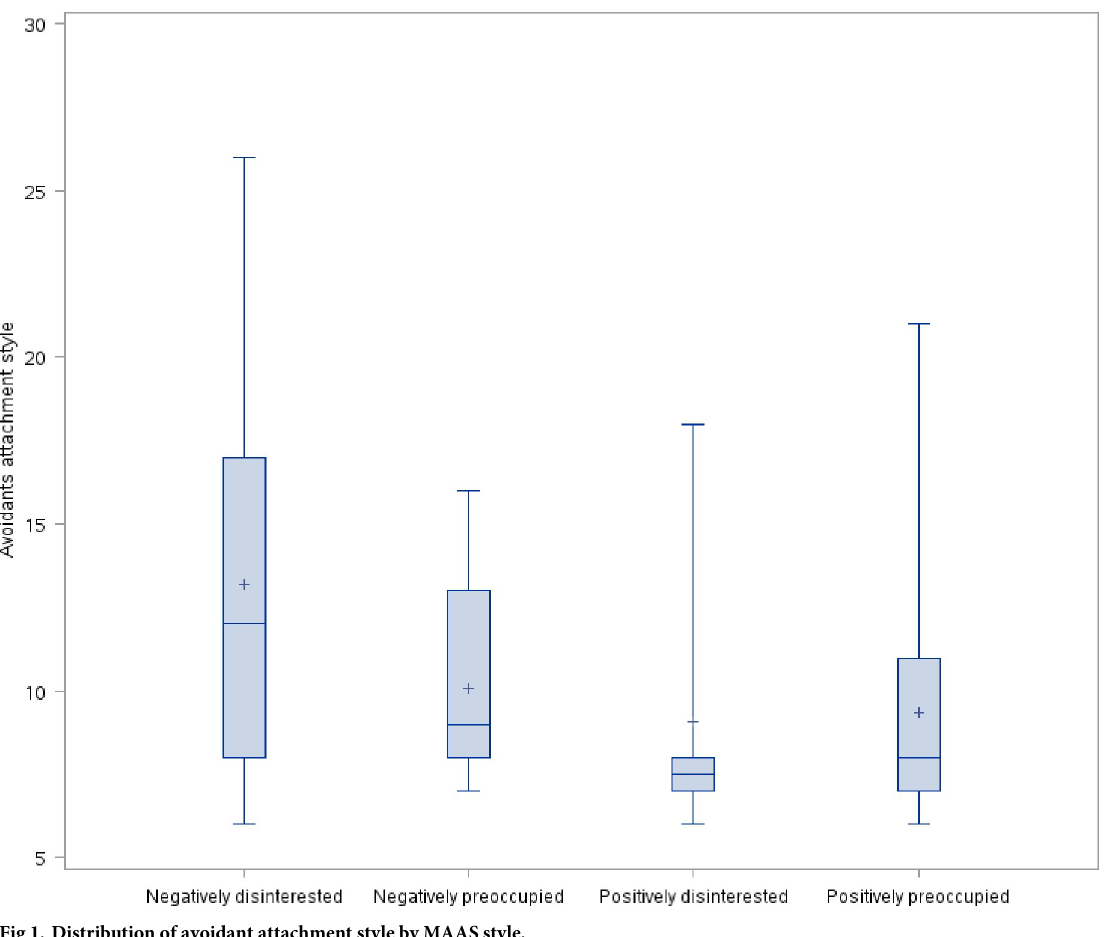
Fig 1. Distribution of avoidant attachment style by MAAS